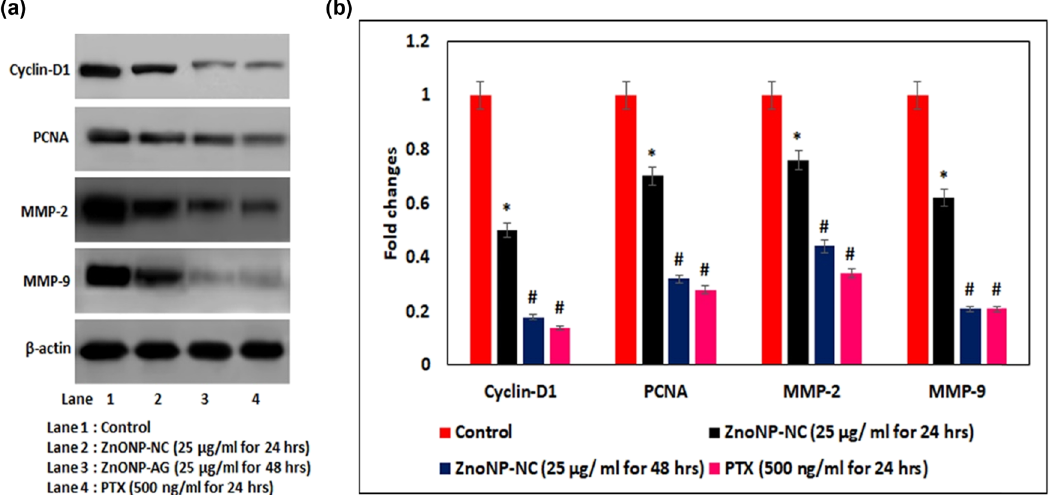
Figure 5: ZnONPs - NC inhibit cell proliferation and invasive markers in SKOV3 cells. ( a ) Western blot studies of ZnONPs - NC treatment - mediated cell proliferation marker ( cyclin - D1 and PCNA ) and invasion marker ( MMP - 2 and MMP - 9 ) in SKOV3 cells; ( b ) quanti fi cation of protein was evaluated by image - J software, and β - actin has served as positive control; it can normalize the interest of protein. Values from the plot are expressed as mean ± SD calculated by